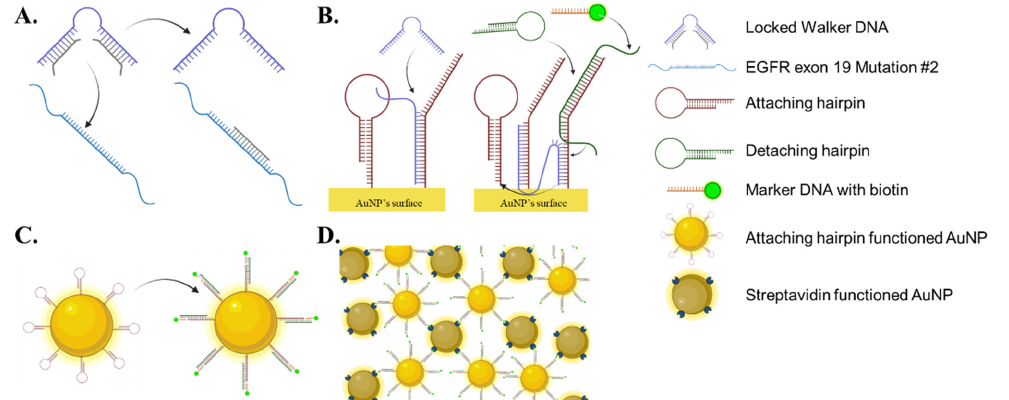
Figure 1. Scheme of working of walker DNA and coupling with the Au NP. ( A ) Locker DNA is bound to walker DNA, until the target DNA (EGFR exon 19 mutant #2) frees the walker DNA by binding to the locker DNA. ( B ) The activated walker DNA opens the attaching hairpin on the AuNP through strand displacement. Following this, the detaching hairpin and marker DNA bind to the attaching hairpin. ( C ) Consequently, biotin molecules are immobilized on the surface of the AuNP. The walker DNA chain reaction continues to the neighboring AuNPs. ( D ) The biotin-immobilized AuNPs bind to the streptavidin AuNPs to produce aggregates.